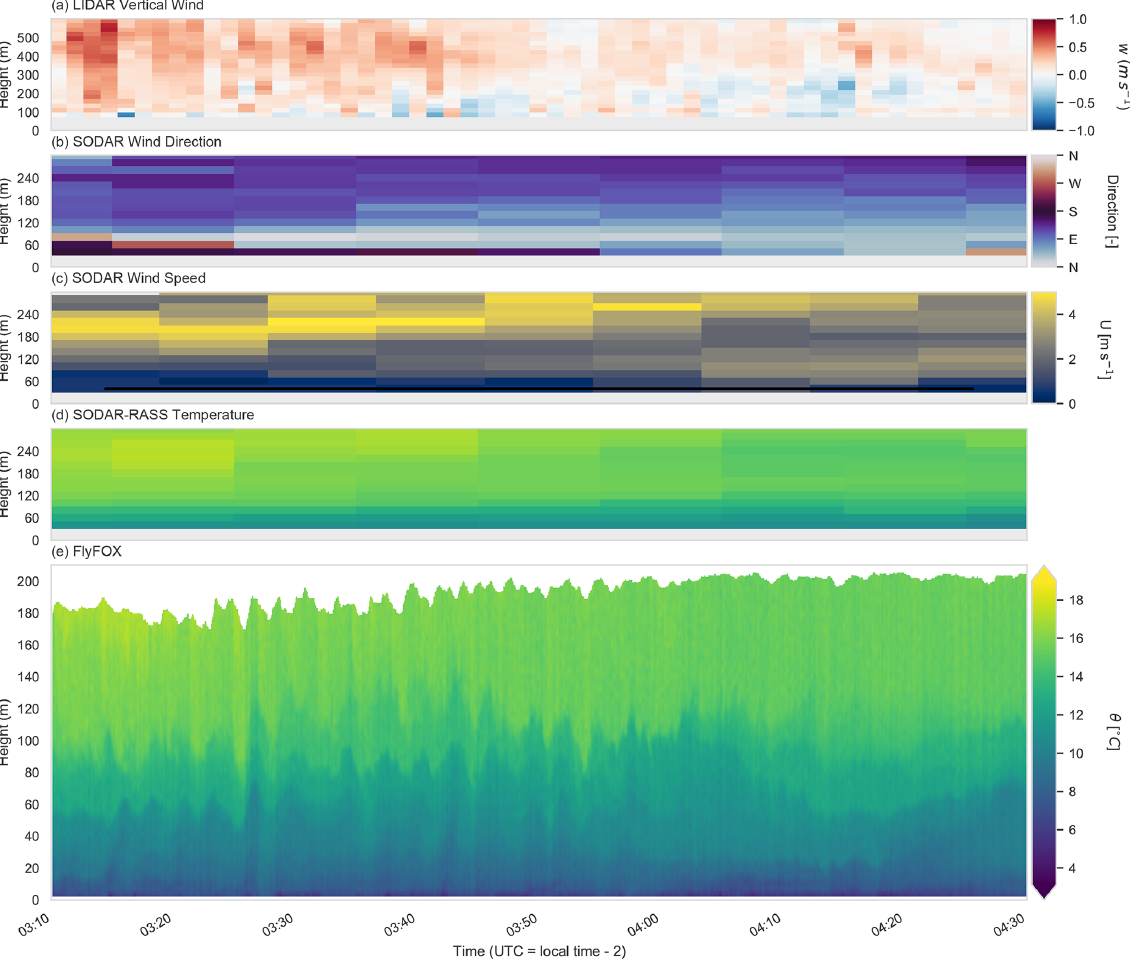
Figure 9. The LOVE19 “column” during the first FlyFOX-V flight on 18 July 2019. (a) The lidar vertical stares yield vertical wind speeds, which are aggregated to 84s. The sodar-derived (b) horizontal wind direction and (c) horizontal wind speed and (d) the sodar RASS potential temperature during the flight. (e) The FlyFOX-V data, converted to potential temperature and height above the